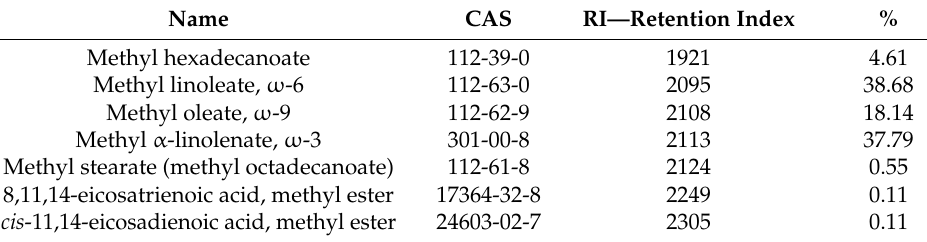
Table 4. Content of compounds in wild bilberry seeds oil determined by GC-MC